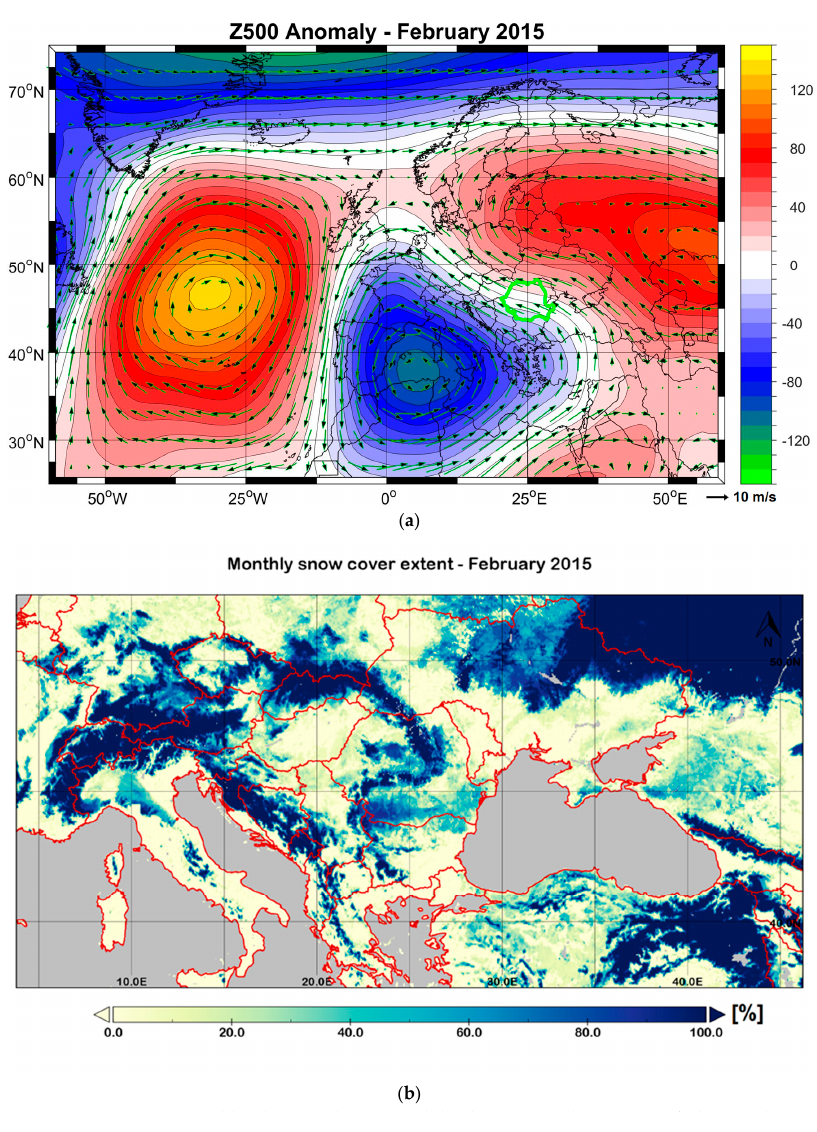
Figure 9. ( a ) Geopotential height anomalies at 500mb level (Z500) in February 2015; ( b ) large scale snow cover in February 2015. The snow cover data was provided by MODIS/Terra Snow Cover. Units: Z500(m).